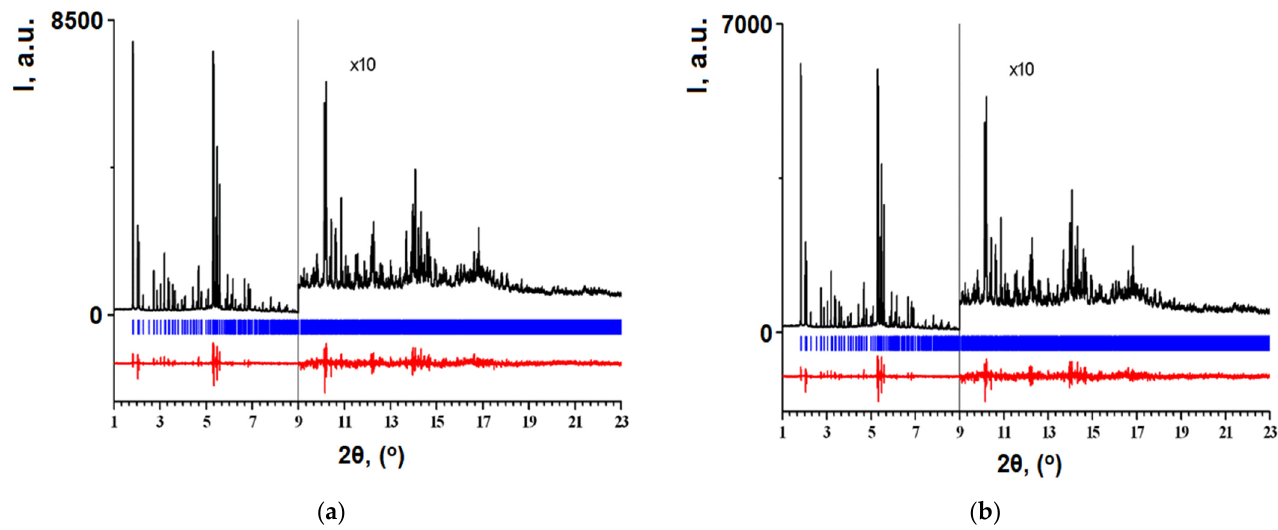
Figure 16. Final profile fit obtained for TS-4 ( а ) and TS-4(348) ( b ) samples (adapted from [34]). The full-profile Rietveld method data analysis (Table 11, Figure 15) revealed that both commercial TS-1, TS-2, and TS-3 and synthesized by us TS-4 titanosilicalites crystallize in orthorhombic symmetry but judging by the unit cell volume their compositions are different: Ti 4+ ions content is higher in TS-3 and TS-2 compared to TS-1 and TS-4. This ratio of titanium and silicon atoms in TS-1, TS-2, and TS-3 and TS-4 (TS-4 > TS-1 > TS-3 >TS-2) is confirmed by FTIR spectroscopy data (Figure 17).